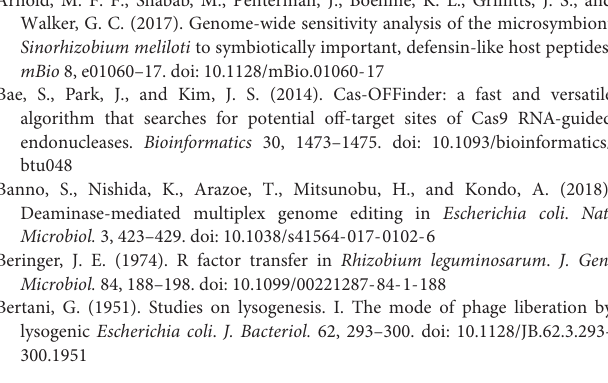
Supplementary Figure 1 | Cas9 protein expression and the A-to-G conversion of ABE systems in S. meliloti . (A) ABE fusion protein expression was assayed using